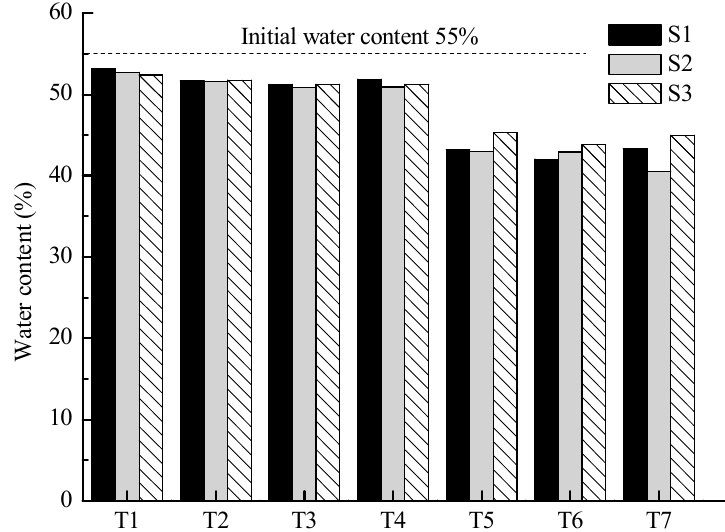
Figure 6. Soil water content after EKR treatment.